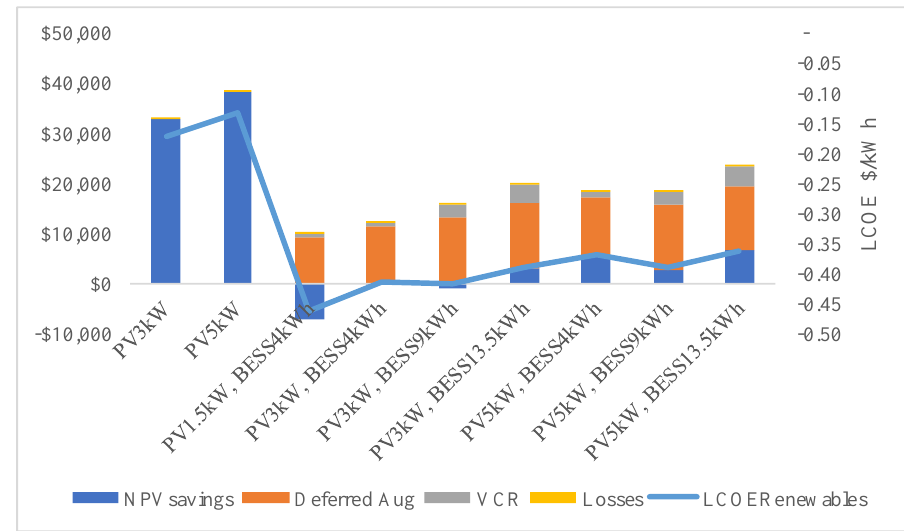
Figure 15. Financial evaluation by equipment mix.